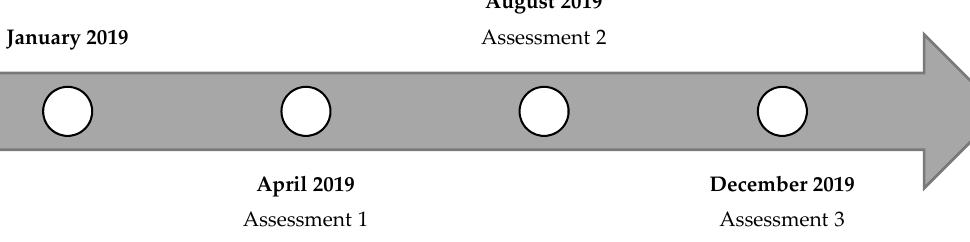
Figure 1. Timeline of assessments during 52 weeks of